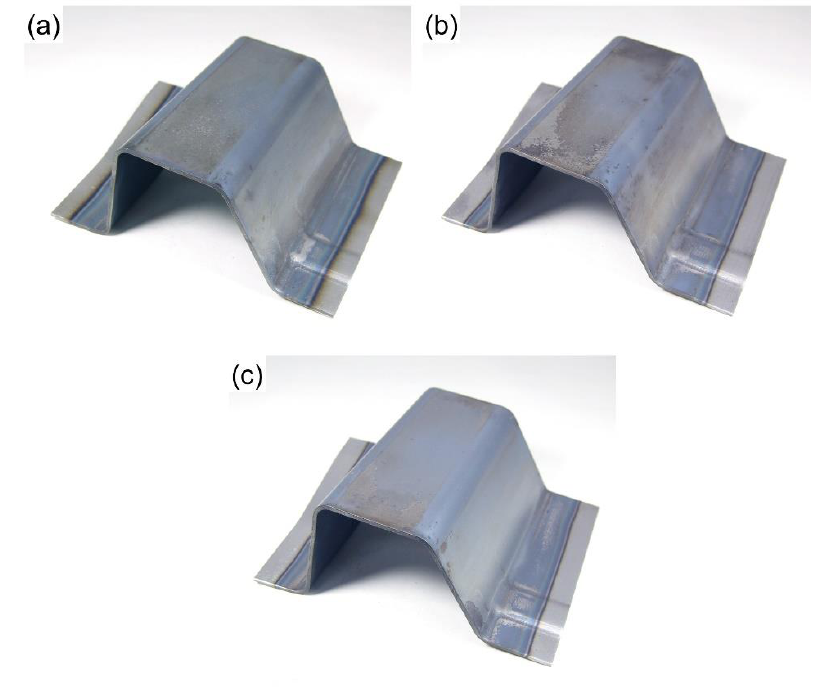
Figure 15. Hot hat-shaped bent parts for v = 275 °C/s and ( a ) t = 0 s, ( b ) 5 s, and ( c ) 10 s.